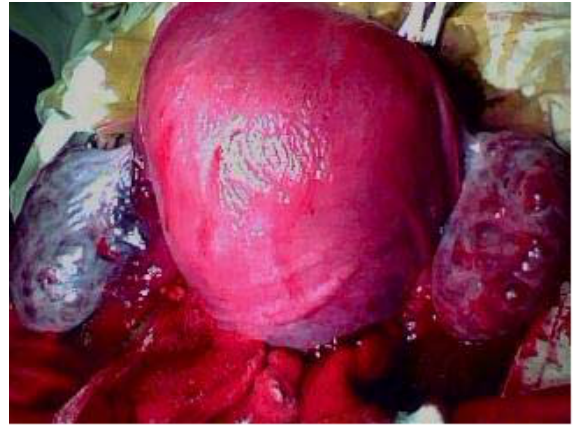
Figure 1. Bilateral enlarged ovaries (6x4x3cm) with multiple hemorrhagic